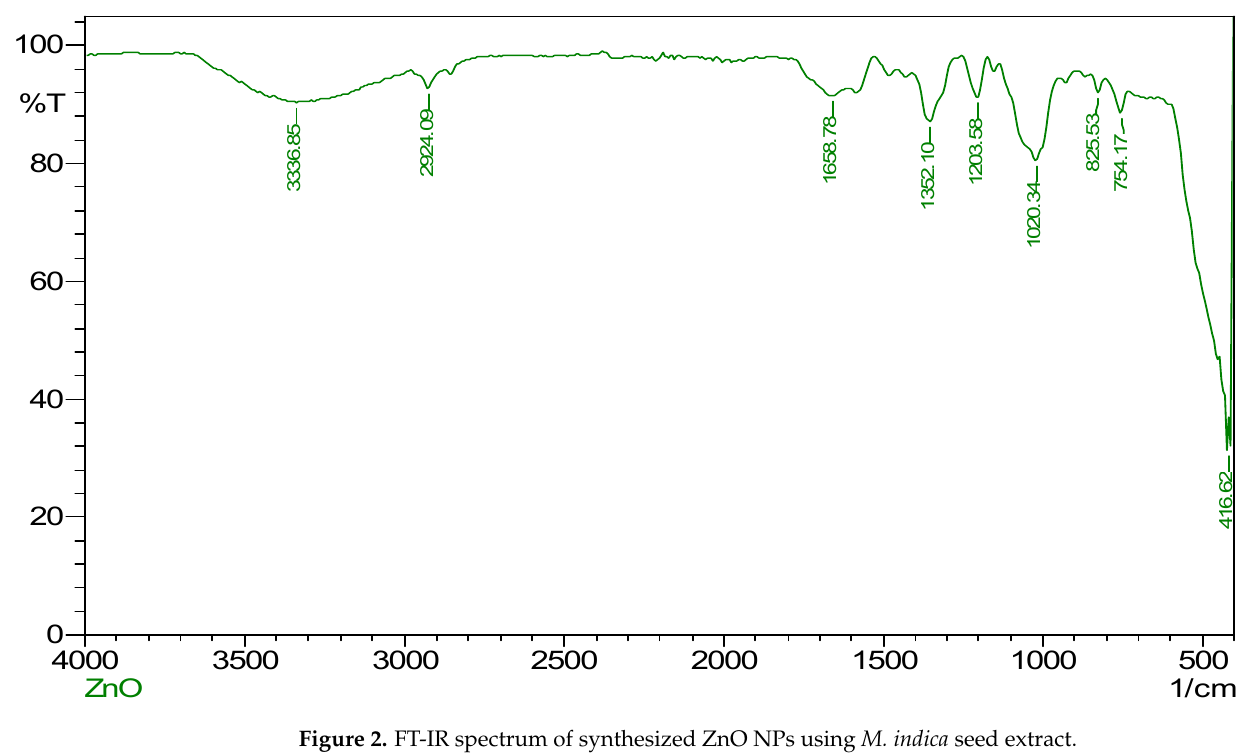
Figure 2. FT-IR spectrum of synthesized ZnO NPs using M. indica seed extract.